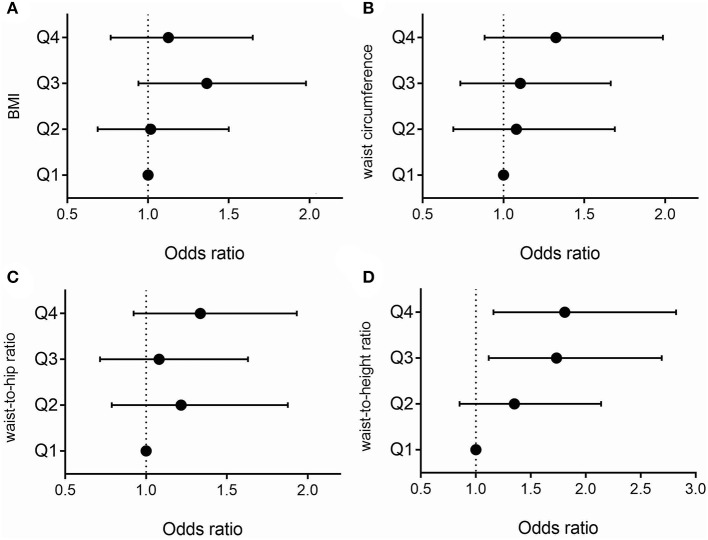
Association between stroke and BMI quartiles (A). Association between stroke and waist circumference quartiles (B). Association between stroke and waist-to-hip ratio quartiles (C). Association between stroke and waist-to-height ratio quartiles (D). Analyses were adjusted for age, sex, area, education, smoking, drinking, hypertension, diabetes, hyperlipidemia, coronary heart disease, family history of stroke, and regular exercise.